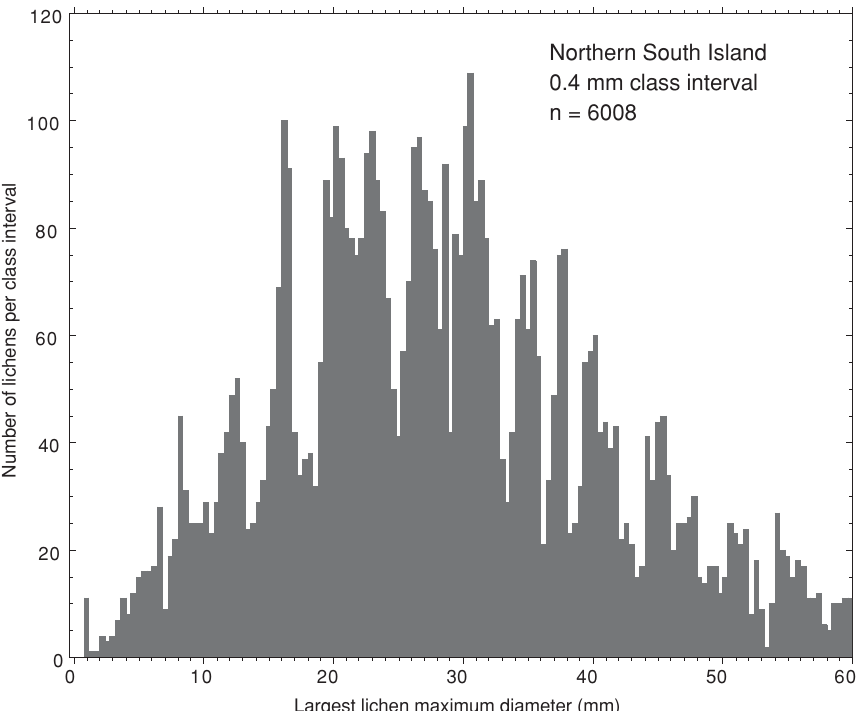
Fig. 7. Histogram of the largest lichen maximum diameters for 6008 rockfall blocks. Measurements were com- bined from 20 lichenometry sites in 20 . 000 km 2 of the northern part of the South Island of New Zealand under- lain by quartzitic greywacke sandstone, syenite, and argillaceous greywacke sandstone. Site altitudes range from 380 to 1620 m. Altitude and macroclimate not affect lichen growth rates as shown by the sharply defined lichen- size